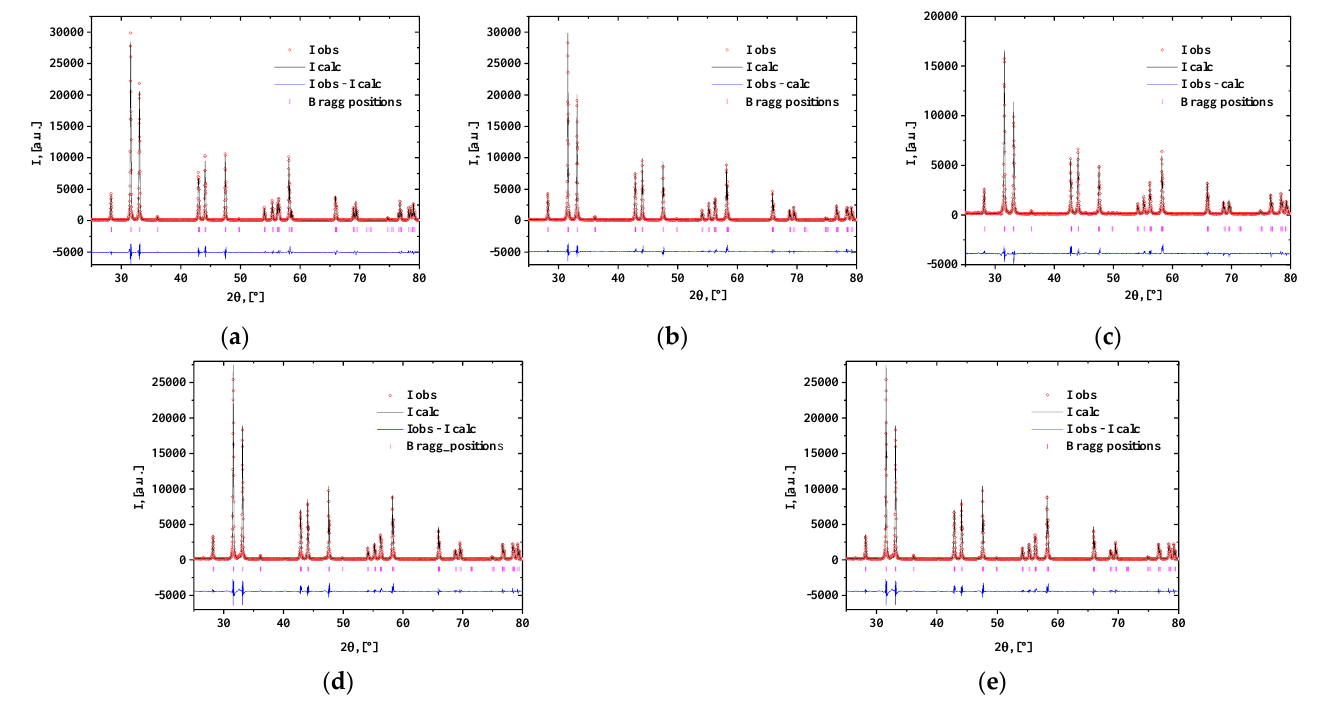
Figure 1. Observed (points) and calculated (lines) XRD patterns for the La 1.7 Ca 0.3 Ni 1−y Cu y O 4+δ powdered samples: ( a ) La 1.7 Ca 0.3 NiO 4+δ ; ( b ) La 1.7 Ca 0.3 Ni 0.9 Cu 0.1 O 4+ δ ; ( c ) La 1.7 Ca 0.3 Ni 0.8 Cu 0.2 O 4+ δ ; ( d ) La 1.7 Ca 0.3 Ni 0.7 Cu 0.3 O 4+ δ ; ( e ) La 1.7 Ca 0.3 Ni 0.6 Cu 0.4 O 4+ δ .